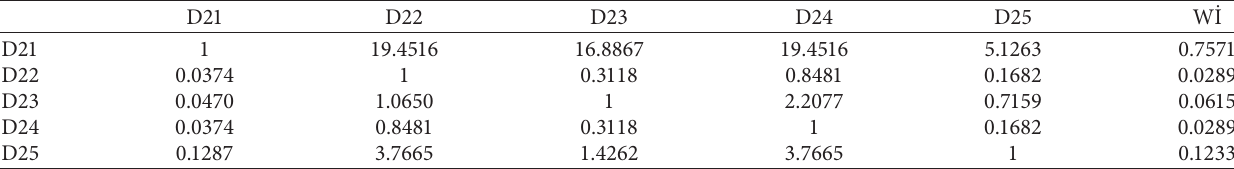
Table 9: Determinacy value matrix.